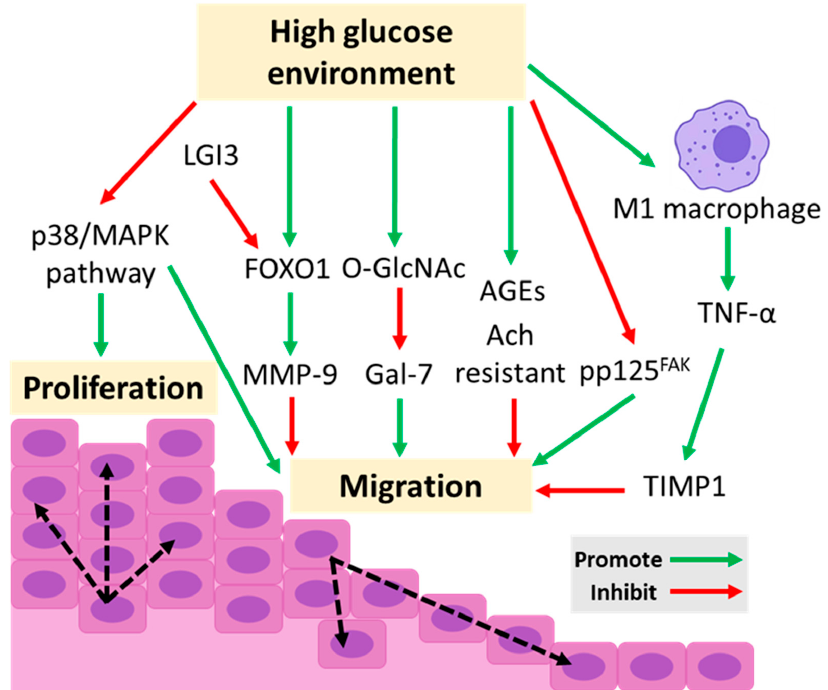
Figure 2. Factors influencing the proliferation and migration ability of keratinocytes in a high glucose environment. The high glucose environment downregulates the expression of phosphorylated p125 FAK (pp125 FAK ) and the p38/mitogen-activated protein kinase (MAPK) pathway, leading to the inhibition of keratinocyte migration. Increased O-linked N-acetylglucosamine (O-GlcNAc) glyco- sylation in a high glucose environment is responsible for reduced Gal-7 expression, which plays an important role in keratinocyte migration. Increased forkhead box protein O1 (FOXO1) in keratino- cytes can stimulate the expression of MMP-9, leading to the impairment of keratinocyte migration. Leucine-rich repeat LGI family member 3 (LGI3) can promote the degradation of FOXO1 through phosphorylation of FOXO1 via the Akt pathway. A high glucose environment stimulates the for- mation of advanced glycation end products (AGEs) and keratinocyte resistance to acetylcholine (Ach), leading to the impairment of keratinocyte migration. A high glucose environment induces M1 macrophage infiltration, followed by the increased secretion of TNF- α , which upregulates tissue inhibitor matrix metalloproteinase 1 (TIMP-1) expression in keratinocytes, resulting in impaired keratinocyte migration. 3.4. Chronic Inflammation In wound healing, the acute inflammatory phase may last 2 weeks. The prolongation of inflammation may impair wound healing. Previous studies revealed that more neutro- phils and macrophages were noted in diabetic wounds [9,15,49,92]. Increased pro-inflam- matory cytokines such as IL-1, IL-6, IL-8 and TNF- α were also found [9,93]. Neutrophils play a crucial role in the inflammatory phase, and it can generate ROS and serine proteases for preventing wound infections. However, prolonged neutrophil infiltration may impair wound healing. Our previous study demonstrated that reducing pro-inflammatory cyto- kines and decreasing neutrophil infiltration promoted diabetic wound healing in a dia- betic rat model [49]. Recent studies revealed the important role of keratinocytes, which secrete various chemokines and pro-inflammatory cytokines in the chronic inflammation of diabetic wounds. We have revealed that increased IL-8 expression from keratinocytes in a high-glucose environment is known to recruit and activate neutrophils that produce ROS, contributing to impaired diabetic wound healing [49,93]. The activation of TNF- α